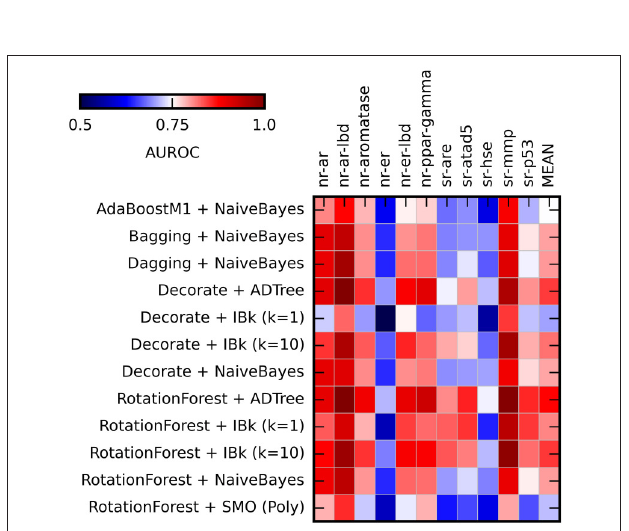
FIGURE 3 | Heat maps presenting results of the ensemble methods assessment. Color coded AUROC values for 12 classifiers (Y axis) for each challenge target (X axis) are shown. Aditional column presenting mean AUROC values is added for classifiers comparison.